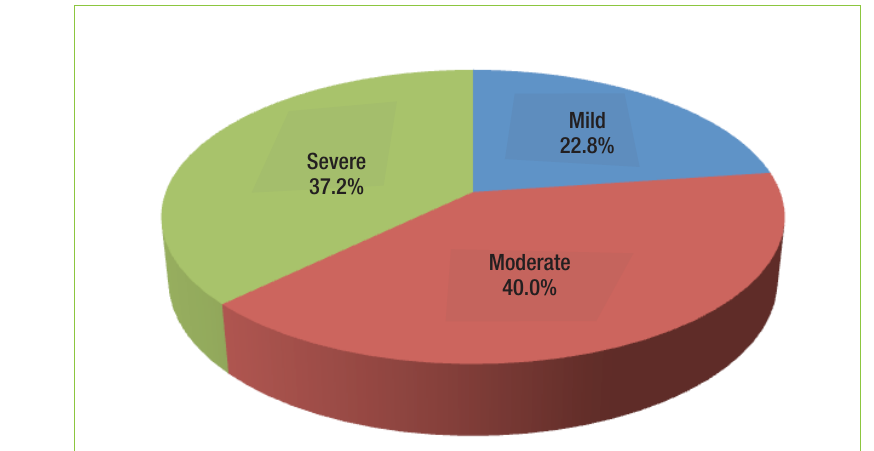
for treatment in health facilities in a 30-day period, Kenya, 2012